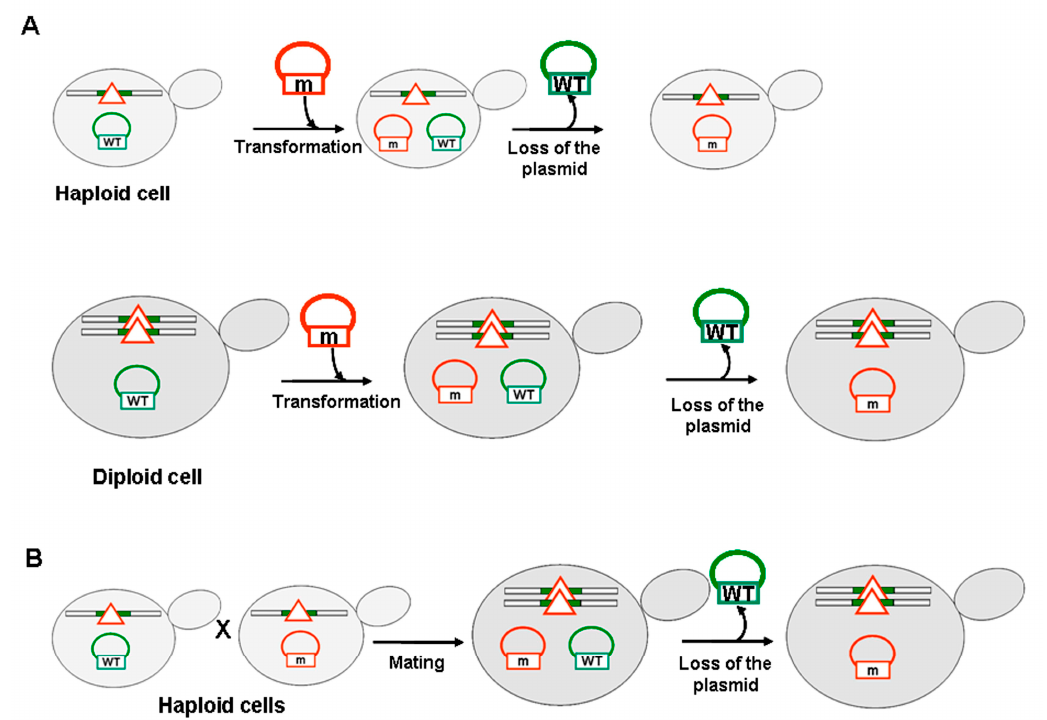
Figure 2. Experimental approaches used to combine sup35-n mutations with the [ PSI + ] prion. ( A ) Haploid [ PSI + ] strain containing wild-type SUP35 gene on the plasmid, was transformed with sup35-n bearing plasmid; resulting transformants were replica plated on 5-FOA medium to select against the [ URA3 SUP35 ] plasmid (upper panel). The same procedure was used for diploid [ PSI + ] strains (lower panel). ( B ) Haploid [ PSI + ] strain, containing wild-type SUP35 gene on the plasmid, was mated to derivatives of a [ psi − ] strain bearing sup35-n plasmid; resulting diploids were replica plated to 5-FOA medium to select against the [ URA3 SUP35 ] plasmid. In all cases isogenic [ psi − ] strains were used as a control. SUP35 wild-type allele (WT) is marked in green, while the mutant sup35-n allele (m) is marked in red. A red triangle indicates non-functional SUP35 gene on the chromosome.